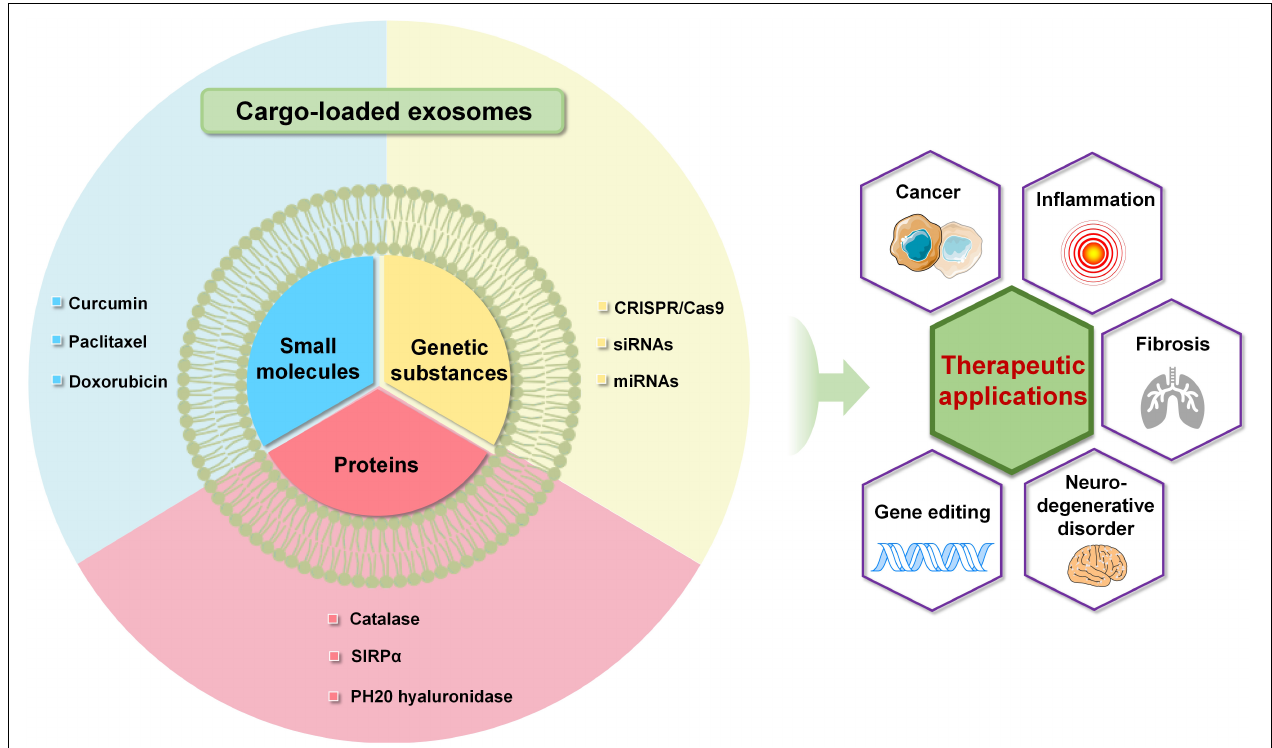
FIGURE 3 | Advanced exosome-mediated delivery systems of small molecules, proteins and genetic substances toward various therapeutic